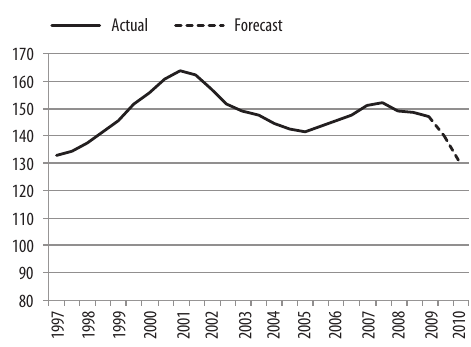
Fig. 10. Ex ante forecast of Helsinki CBD office rents until August